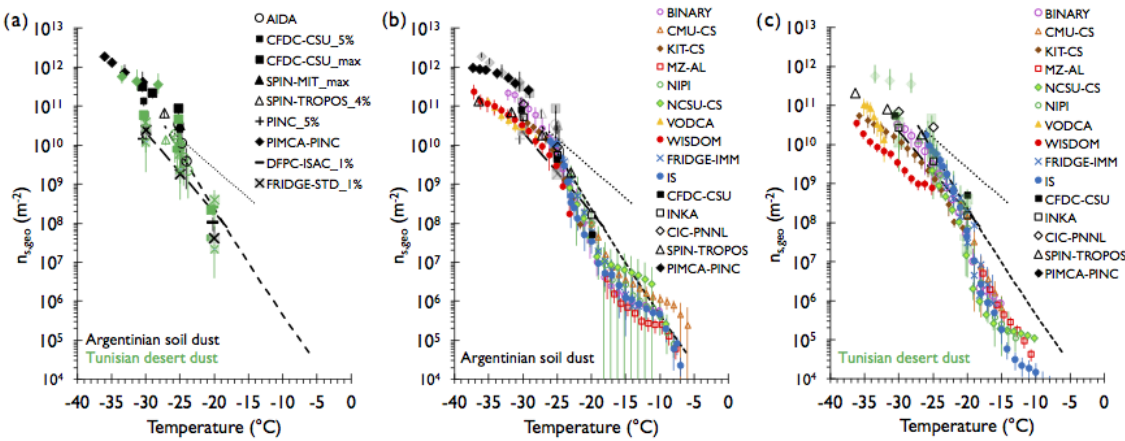
Figure 10. As in Figs. 8 and 9, but for Argentinian soil dust and Tunisian soil dust sample experiments. (a) Data from FIN-02 AIDA experiments 5 (16 March 2015), 9 (19 March 2015), 24 (26 March 2015), and 26 (27 March 2015) are represented for Argentinian soil dust, and AIDA experiments 7 (18 March 2015) and 12 (20 March 2015) are represented for Tunisian soil dust, as listed for different instruments in Table S1. AIDA cloud expansion results are represented only for AIDA experiments 7 and 9, when mixed-phase clouds formed and persisted. Two fits of n s , geo (T ) for previous surface soil dust particle types reported in the literature are from Tobo et al. (2014) (“Wyoming soil dust”, long-dashed) and O’Sullivan et al. (2014) (“fertile soil dust”, short-dashed), and Steinke et al. (2016) (“agricultural soil dust”, dotted). APC data from Fig. 4 for Argentinian dust and Fig. 5 for Tunisian dust are overlain in panels (b) and (c) ,